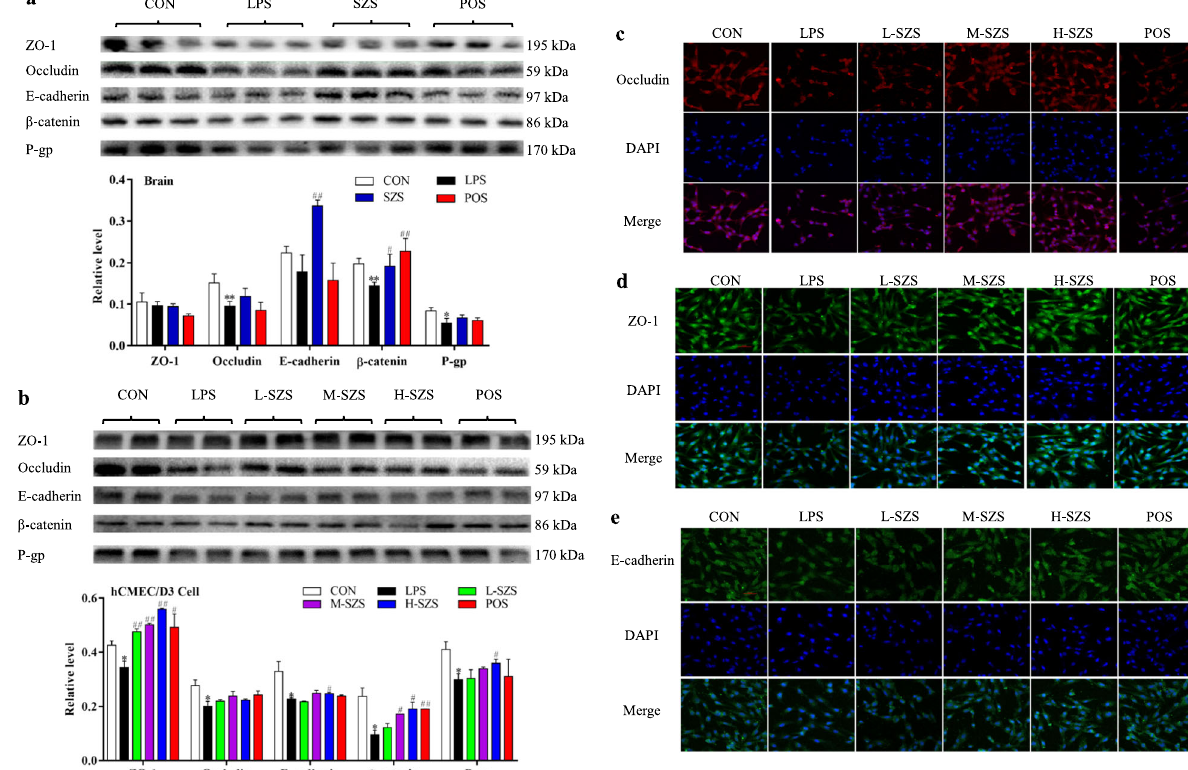
Fig. 3 SZS increases the expression of junction proteins, P-gp. The expression of ZO-1, occludin, E-cadherin, β -catenin, P-gp, and the ratio of F/G-actin in rat brain ( a ) and hCMEC/D3 cells ( b ) was determined by western blot analysis. Immuno fl uorescence (IF) staining was used to examine the expression and distribution of occludin ( c ), ZO-1 ( d ), and E-cadherin ( e ) in hCMEC/D3 cells for all groups (the length of scale bars were 50 μ m). Data for the western blot were normalized with total protein levels as an internal reference, and the total protein gels are shown in Supplementary Figure 1. All blots or gels derive from the same experiment and that they were processed in parallel. Data are expressed as the mean ± SD ( n = 9). The doses of L-SZS, M-SZS, and H-SZS were 50, 100, and 200 μ g/mL, respectively. Compared with the CON group, * P < 0.05 and ** P < 0.01. Compared with the LPS group, # P < 0.05, ## P <